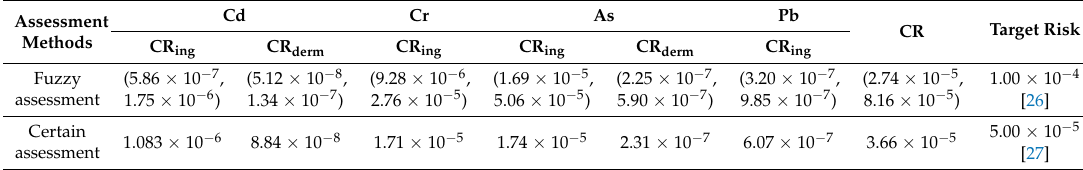
Table 6. Carcinogenic risk (CR) of trace elements in surface water from Honghu